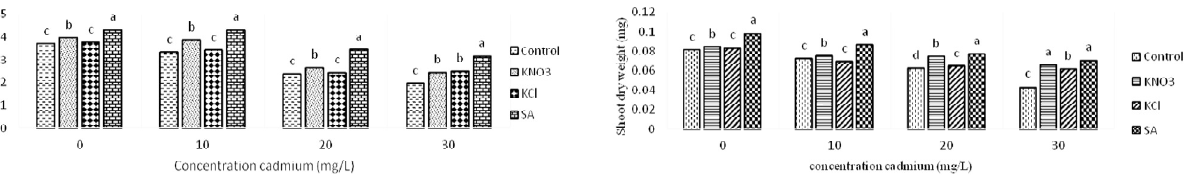
Fig. 5. Shoot dry weight of unprimed (UPS) and primed (PS) seedling of fenugreek ( Trigonella foenum-graecum L.) under different Cd concentrations Shoot dry weight was measured in unprimed seeds and when seeds were primed by 100 mg/L SA and -1 MPa KNO 3 and KCl solution for 24 h. The unprimed seeds were used as the control. Means with similar letters were not significantly different (p ≤ 0.05) based on LSD test. Table 2. Analysis of variance (mean square) for effects of seed priming on, root dry weight, shoot dry weight and vigor index of fenugreek